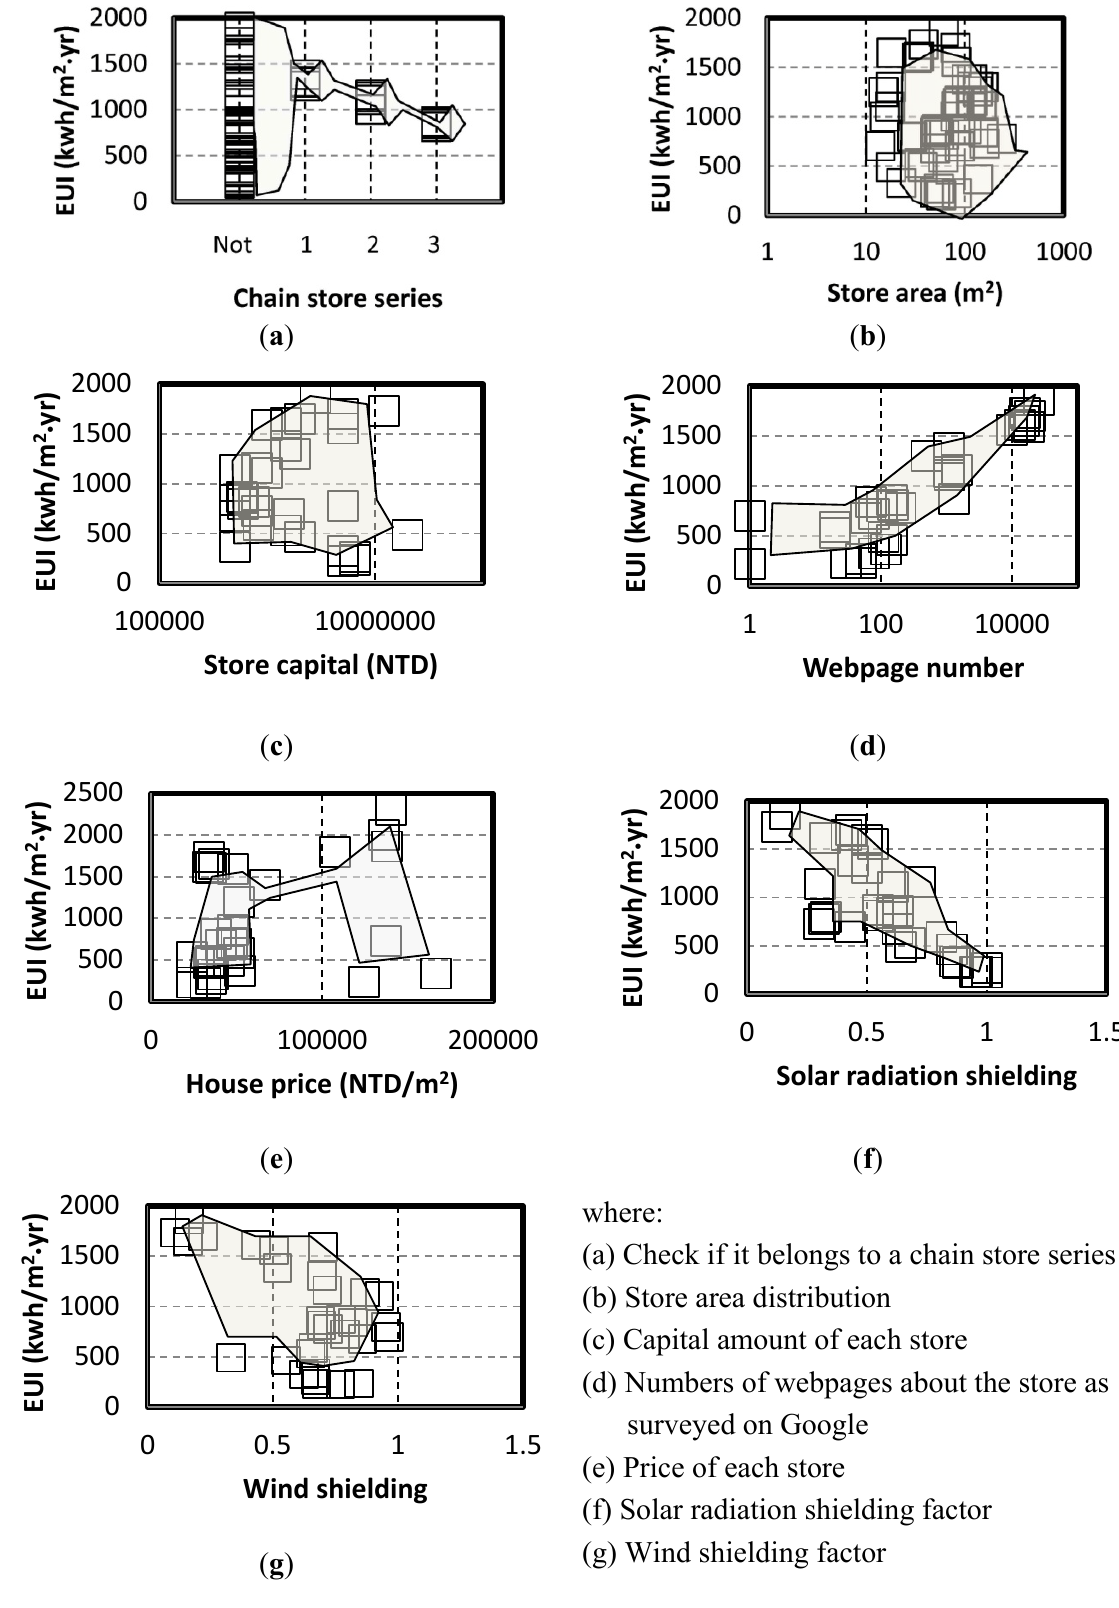
Figure 4. All data collection from 67 stores according to pre-defined URL list and data envelop